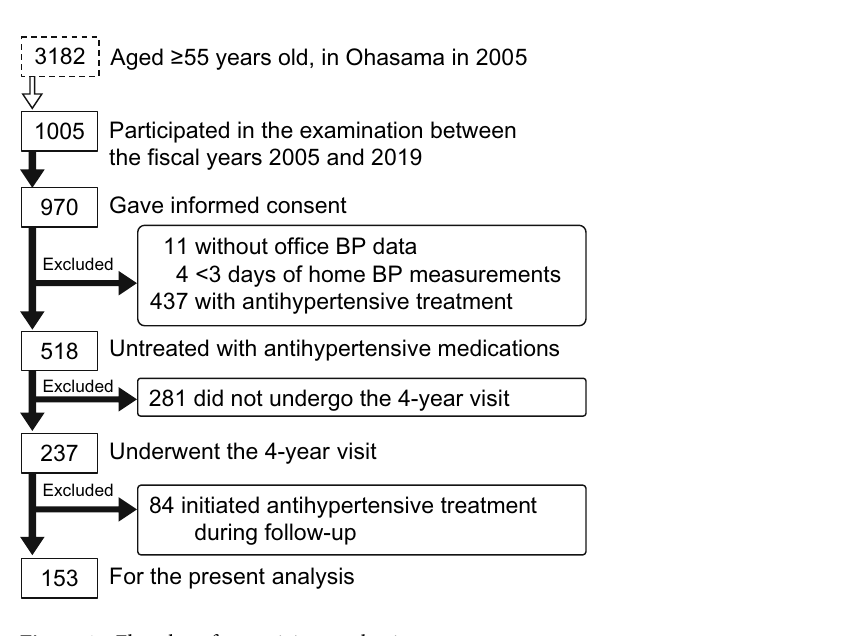
Figure 1. Flowchart for participant